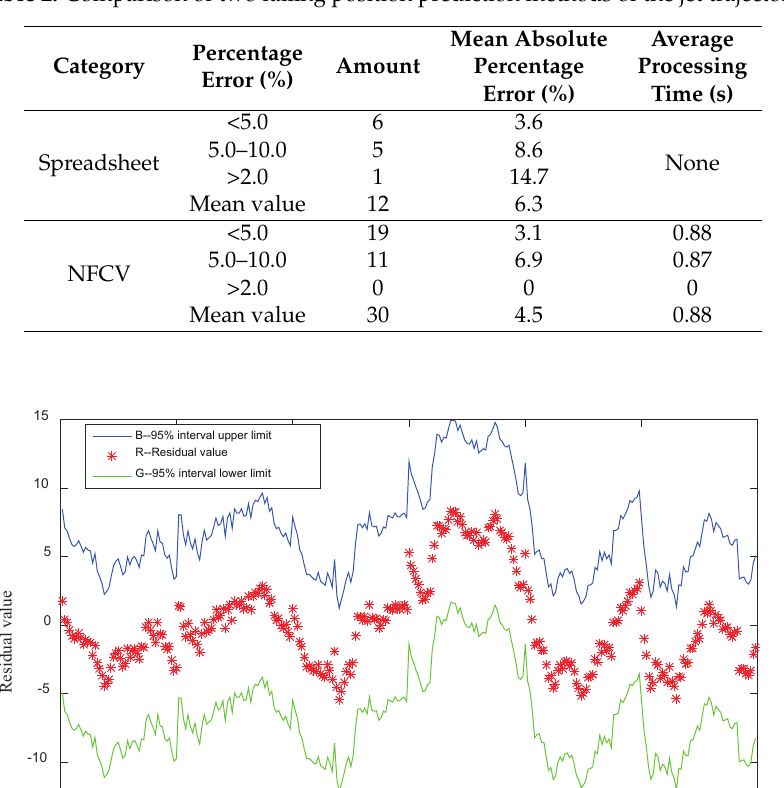
Table 2. Comparison of two falling position prediction methods of the jet trajectory.